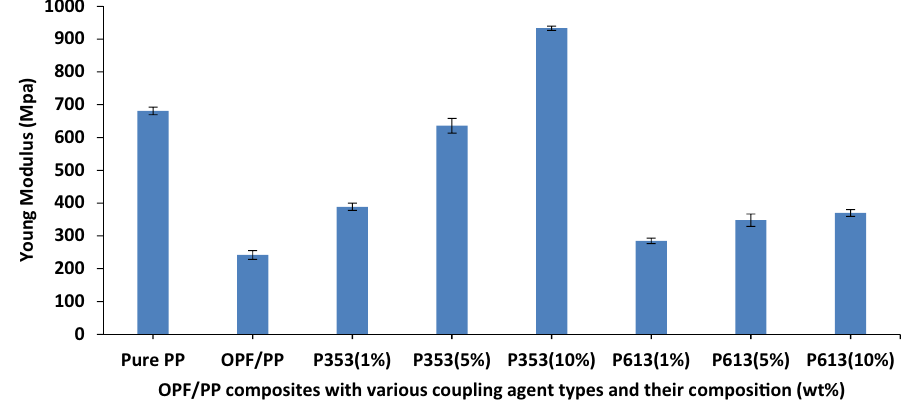
Figure 6: Young ’ s modulus of the pure PP, uncoupled, and coupled 20% OPF/PP polymer composite with two coupling agent types of di ff erent weight